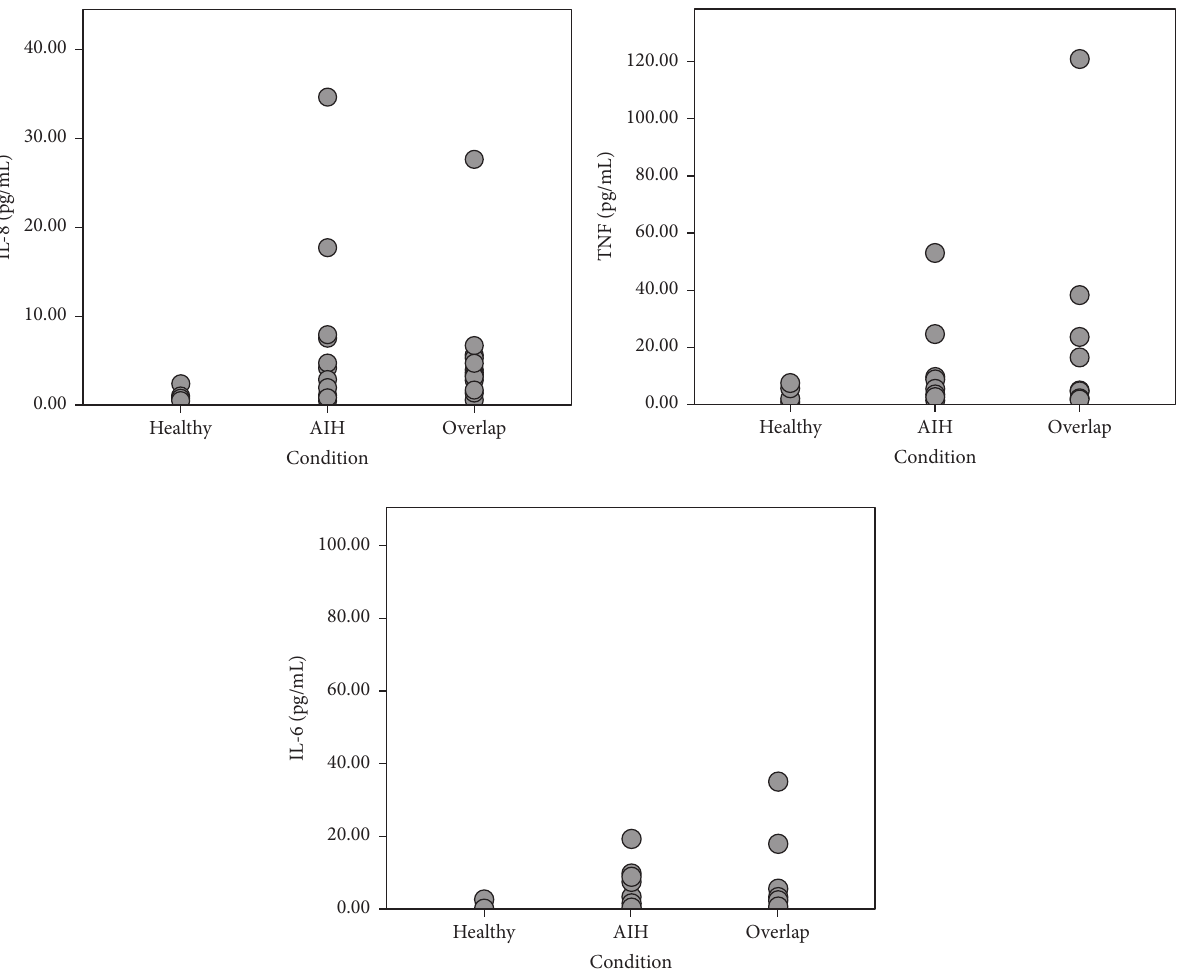
Figure 1: Circulating serum interleukin-8, tumour necrosis factor- 𝛼 (TNF- 𝛼 ), and interleukin-6 concentrations in patients with autoimmune hepatitis (AIH) and overlap syndrome and in healthy controls. Differences between the AIH and control groups and between overlap and control groups are significant for all cases, 𝑝 < 0.01 .